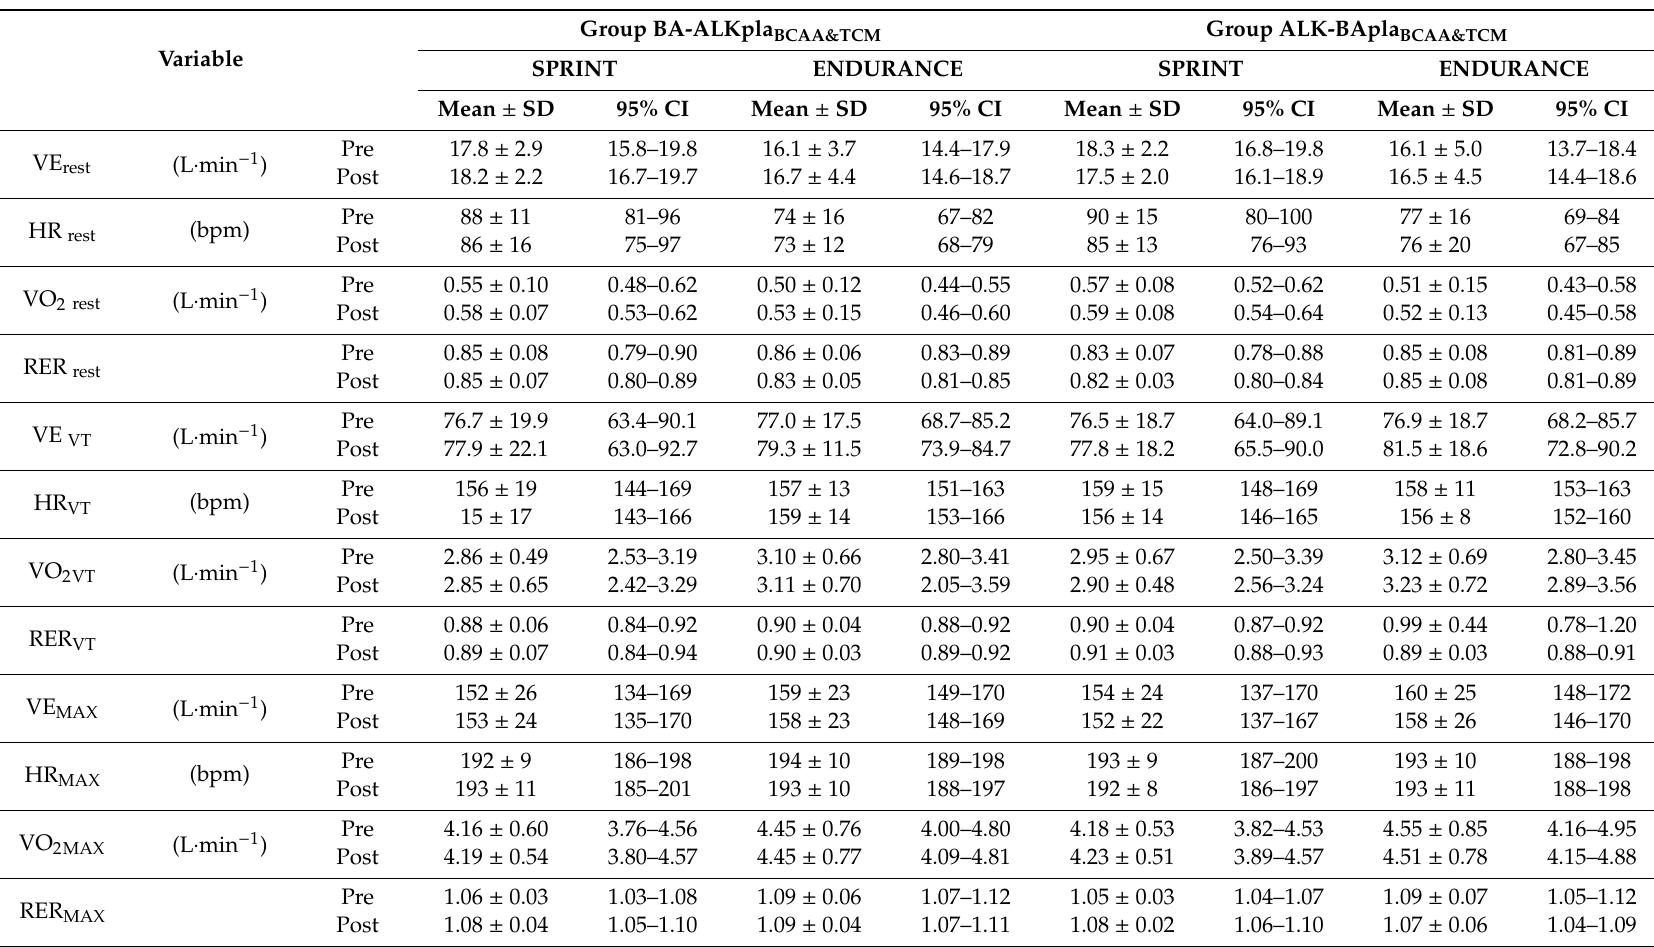
Table 2. Resting and exercise respiratory and aerobic capacity indices of sprinters and endurance athletes before and after